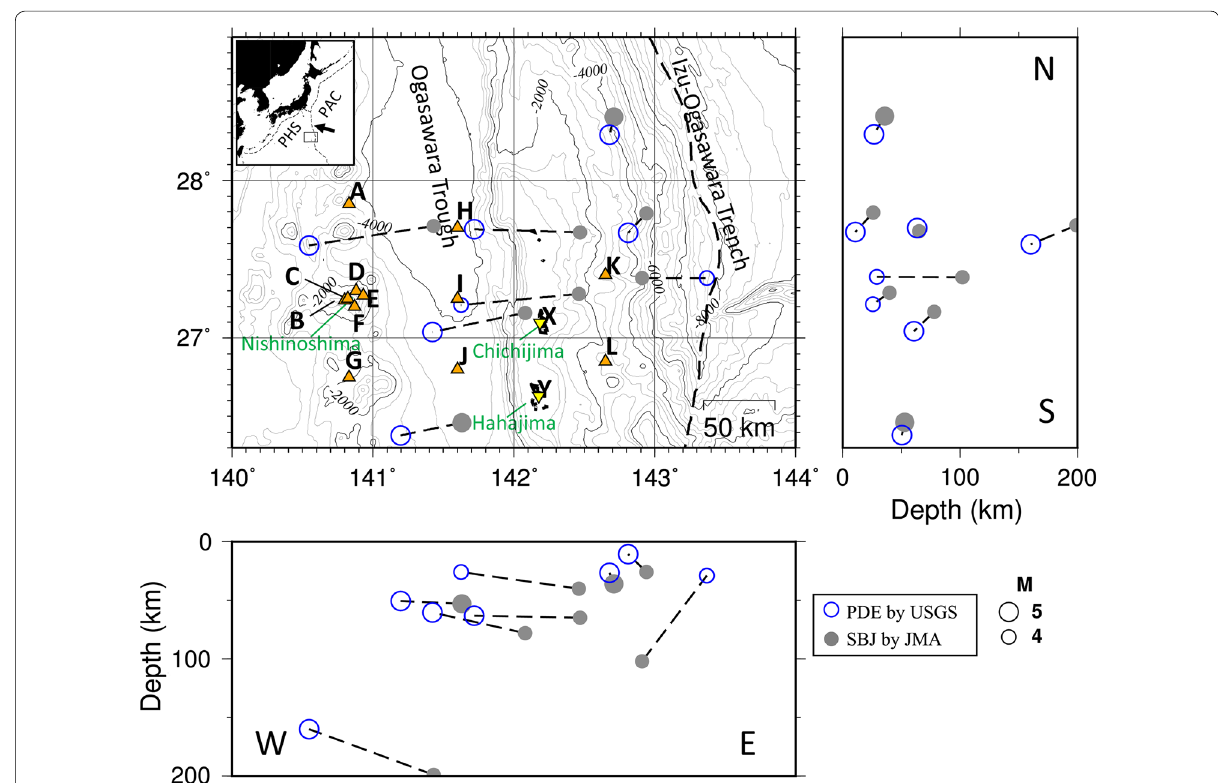
Fig. 1 Comparison of hypocenter locations observed in 2013: gray circles, SBJ; blue circles, PDE. The locations of OBSs (orange triangles) and the land stations on Chichijima and Hahajima (inverted yellow triangles) used in this study are also shown. The bathymetry (gray lines) is shown with a contour interval of 500 m. The inset map shows the area of this study and the direction of movement (arrow) of the Pacific plate (PAC) relative to the Philippine Sea plate